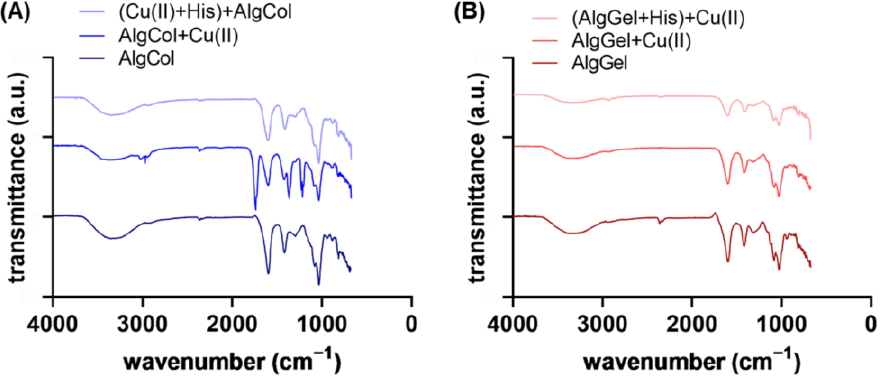
Figure 3. FTIR spectra for ( A ) AlgCol and ( B ) AlgGel before and after copper adsorption. No significant difference was found in the spectra after adding histidine to the AlgCol system, even after 24 h of contact between AlgCol and histidine (Figures S3 and 2). However, a slight intensity reduction in the overall spectra was observed for all the AlgGel peaks. As for the XRD analysis, this result may indicate a predilection of histidine interaction